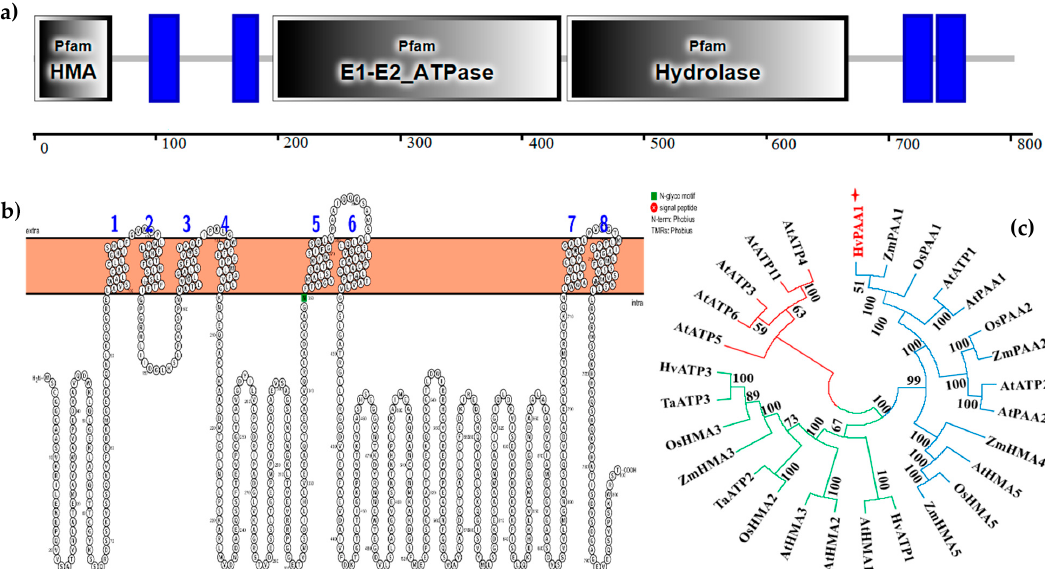
Figure 3. Logarithm of odds (LOD) score profiles for Cd tolerance in terms of shoot Cd concentration. The map positions are indicated along the abscissa. The LOD scores are indicated along the y -axis. The dashed lines represent the LOD score threshold (2.5) at a 0.05 error level for QTL detection.